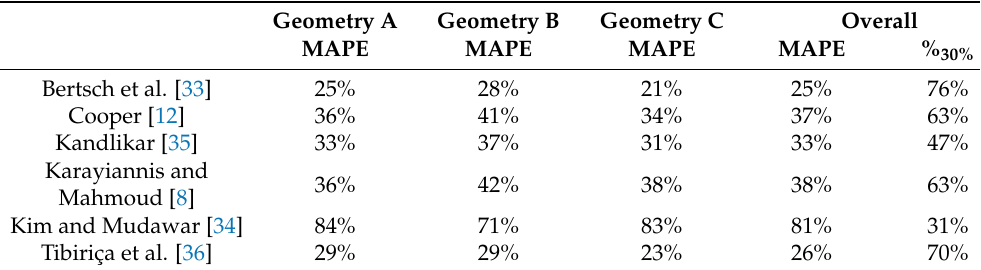
Table 4. Mean Absolute Percentage Error (MAPE) on the prediction of h tp and overall share of the predictions with MAPE below 30% (% 30% ) for the selected